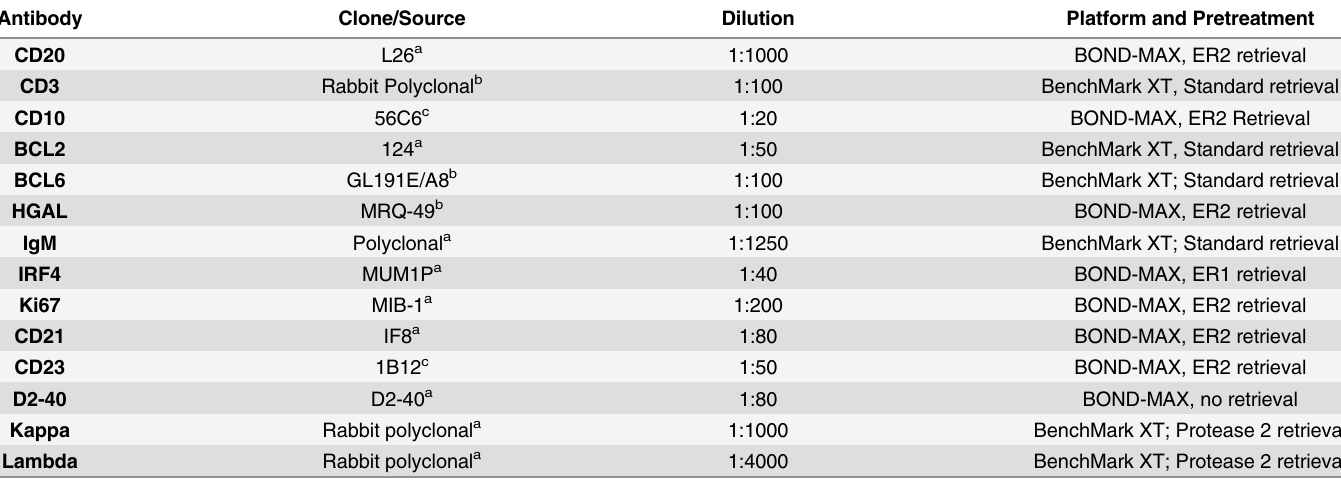
Table 1. Reagents and Conditions Used for Immunohistochemistry.